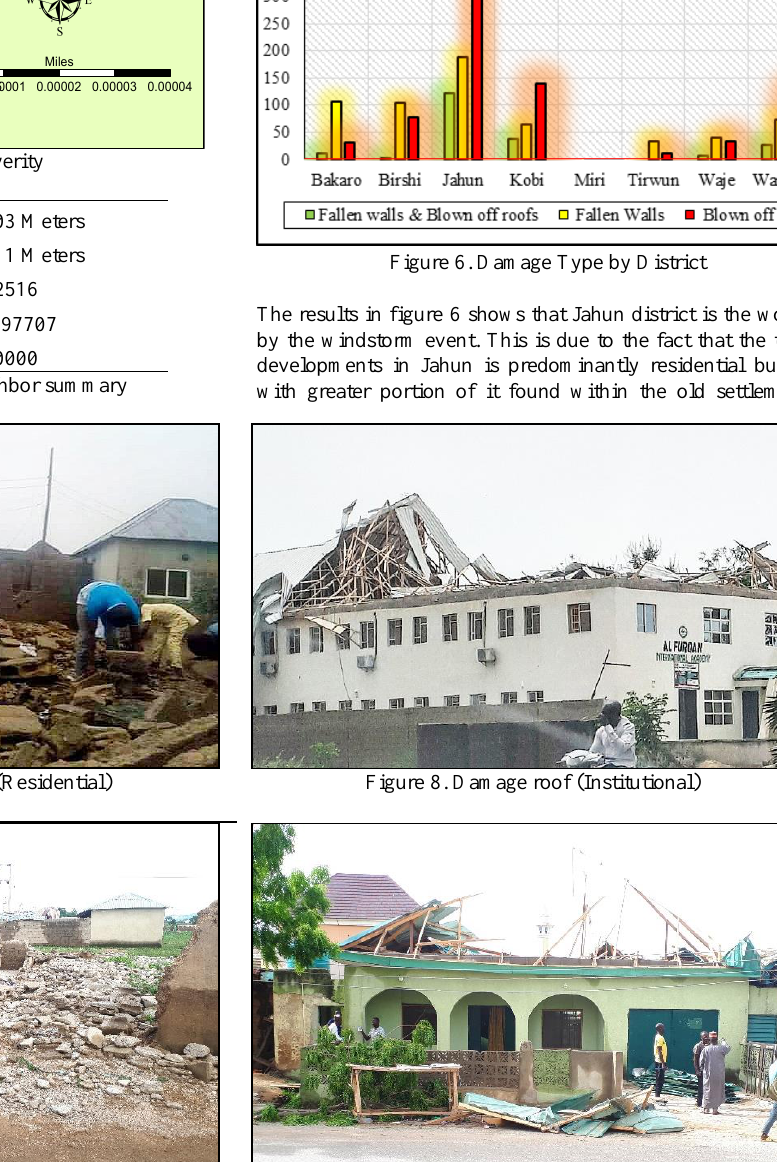
Figure 5. Damage Severity